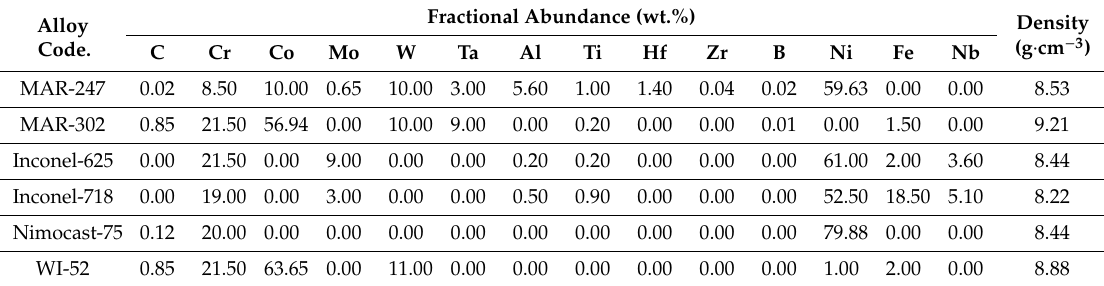
Figure 1. The geometry used for the gamma-ray shielding simulation. Table 1. The chemical composition of the selected alloys in (wt.%). Alloy